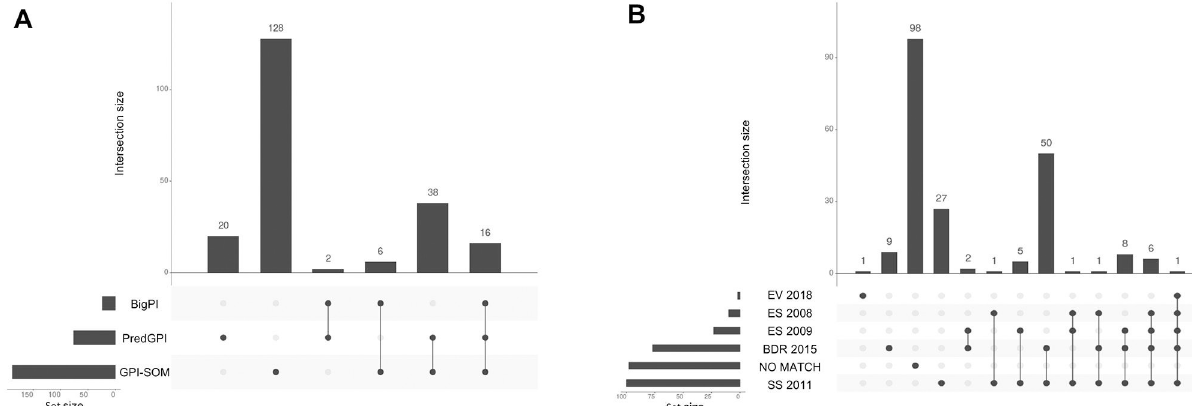
Fig 3. UpSetR analysis of B . malayi predicted GPI-APome and proteomic comparison. (A) Predicted GPI-APs from GPI-SOM, PredGPI and bigPI . Over half of the proteins are exclusive to either PredGPI or GPI-SOM prediction sets and are designated with a single dot. 16 proteins were identified by all three GPI-AP prediction programs as indicated by three linked black circles and 46 were identified by two GPI-AP prediction programs as indicated by two linked black circles. (B) The predicted GPI-APome was compared to previous B . malayi proteomic datasets. EV 2018 [54] is an extracellular vesicle proteome with one predicted GPI-AP in common with all other proteomes and one predicted GPI-AP exclusive to itself. ES 2008 [55] and ES 2009 [56] are the excretory and secretory proteomes and BDR 2015 [57] is the body wall, the digestive tract and the reproductive tract proteomes. SS 2011 [58] is the stage specific proteome set. No Match indicates GPI-APome proteins not found in these five proteomic studies. The set size shown on the left of each graph indicates the number of proteins in each set.